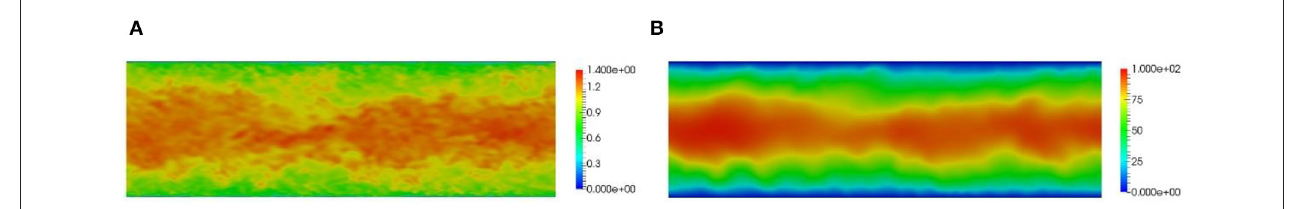
Frontiers in Energy Research |